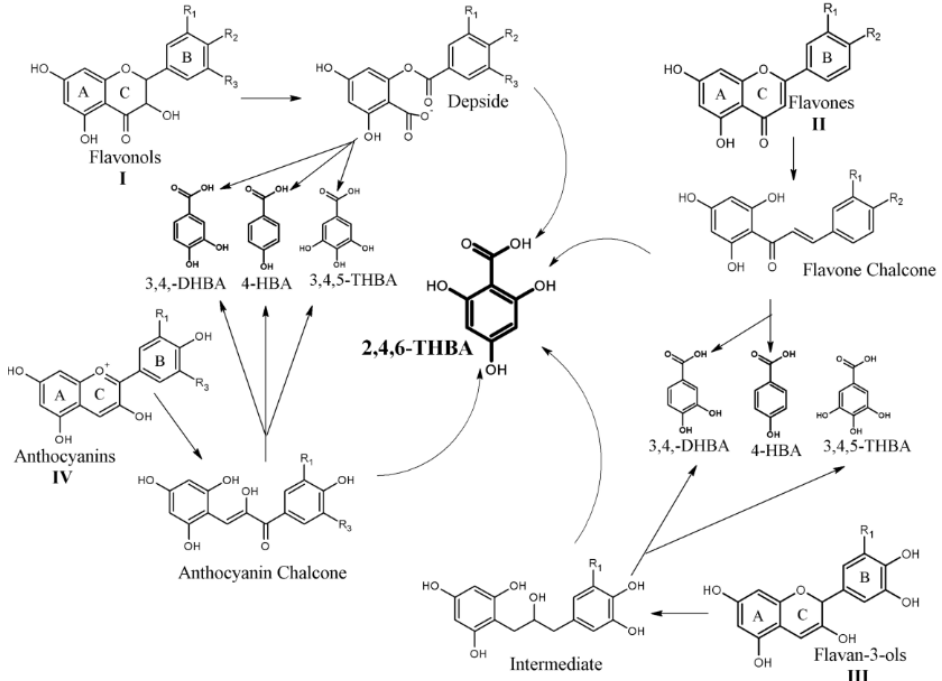
Figure 1. Postulated degradation pathways of selected flavonoid compounds to generate 2,4,6-THBA, 4-HBA, 3,4-DHBA and 3,4,5-THBA. The parent flavonoid compounds (labelled with roman